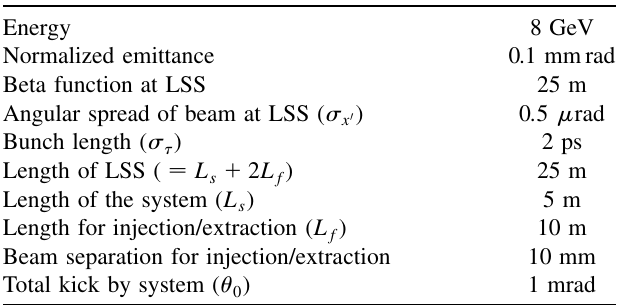
TABLE I. Sample parameters of SPring-8 storage ring based ERL light source with a multiturn circulation system at a long straight section (LSS). The definition of the dimensional pa- rameters is shown in Fig. 9.